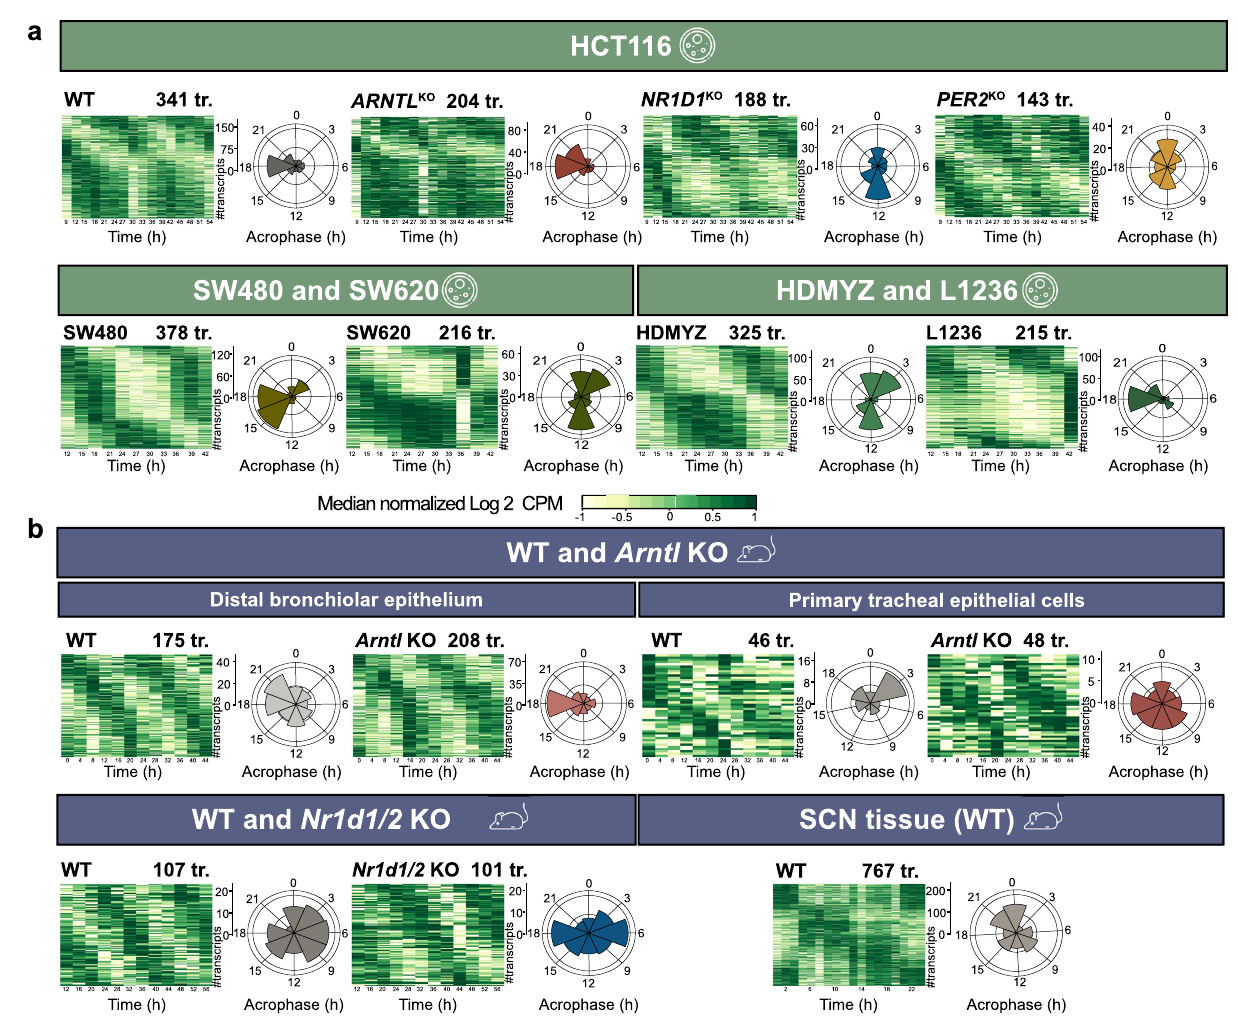
Fig. 2 Circadian expression of splicing factors and spliceosome machinery related transcripts in mammalian RNA-seq datasets. Median normalized phase-sorted heatmaps (left) and acrophase bins (right) of SFs circadian transcripts (tr.) in ( a ) HCT116_WT and HCT116 KO cells (upper panel), SW480 and SW620 cell lines (lower left panel), HDMYZ and L1236 cell lines (lower right panel), b murine WT and Arntl KO from distal bronchiolar epithelium tissue (upper left panel) and from primary tracheal epithelial cells (upper right panel), murine WT and Nr1d1/2 KO from epithelial cells (lower left panel), and murine SCN WT tissue (lower right